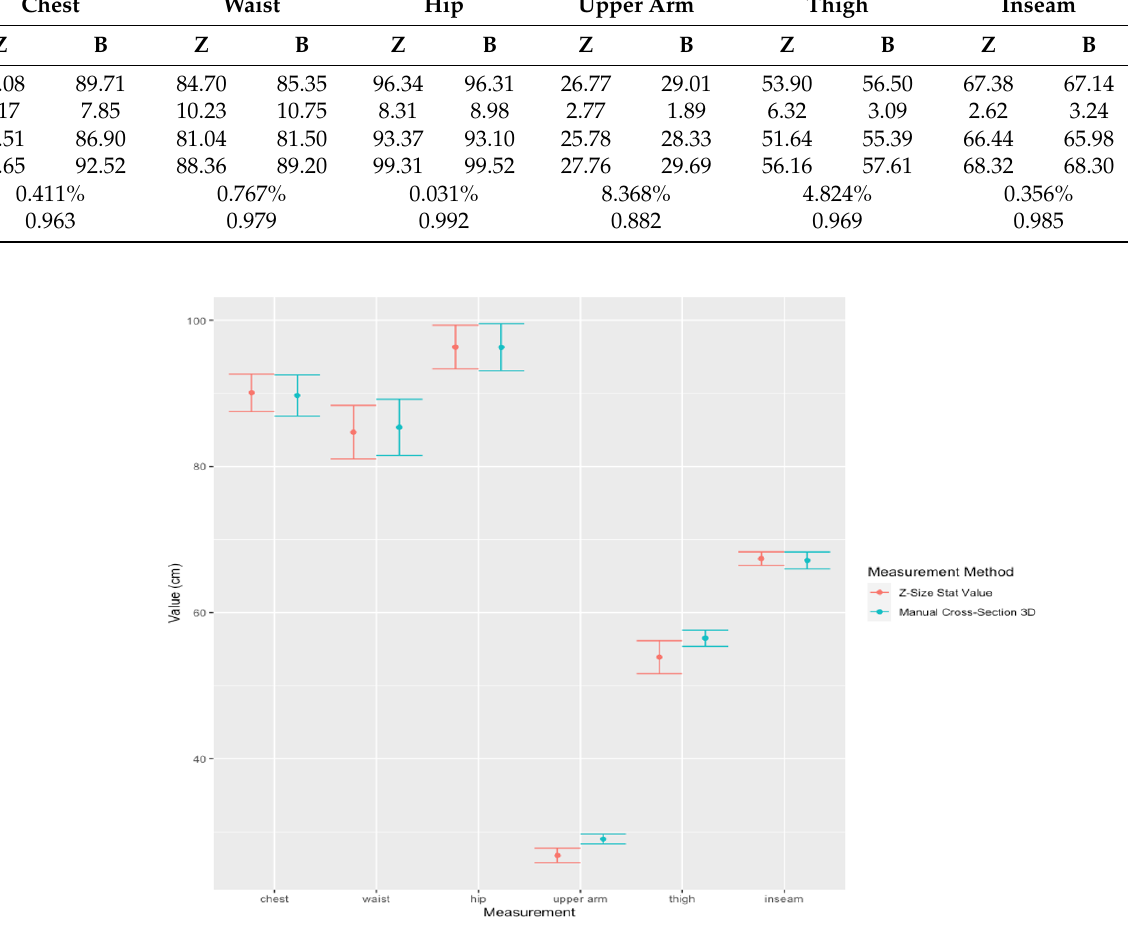
Figure 9. 95% Confidence Interval (CI) plot for the mean measurements (30 data from postpartum) of chest, waist, hip, upper arm, thigh, and inseam between Z-Size Ladies statistical values and manual cross-section 3D values. Table 14. Comparing the average weight measurement, chest, waist, hip and upper arm circumference with the standard deviation and the correlation between the Z-Size Ladies statistical value and the value measured by tape measurement on 74 postpartum